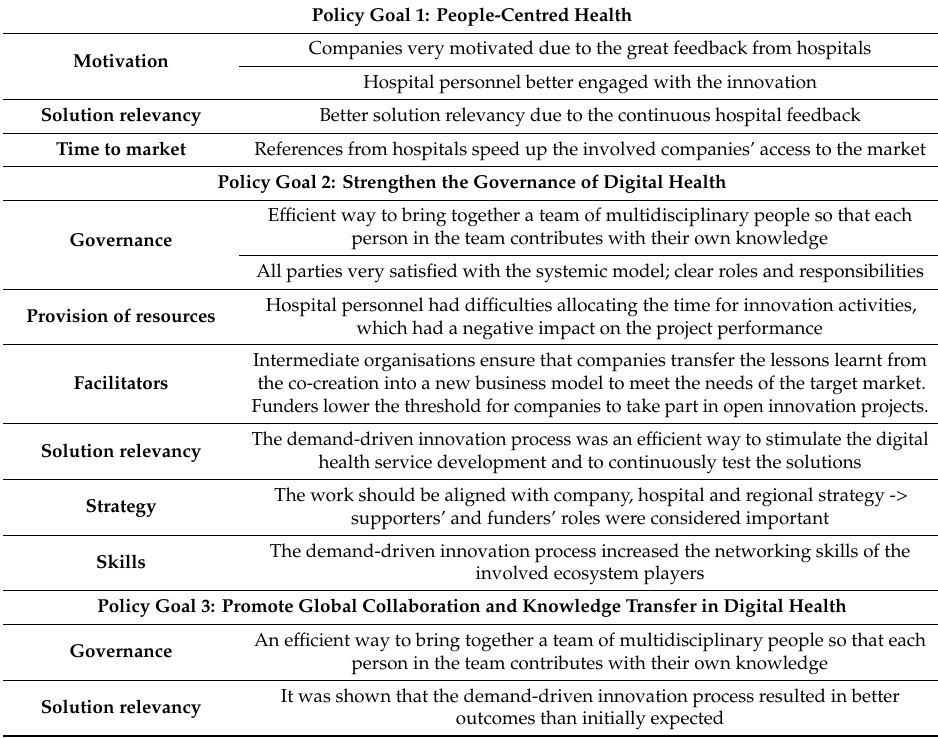
Table 4. Success factors (modified based on Panne, Beers and Kleinknecht [5,6] of demand-driven open innovation compared to the global digital health